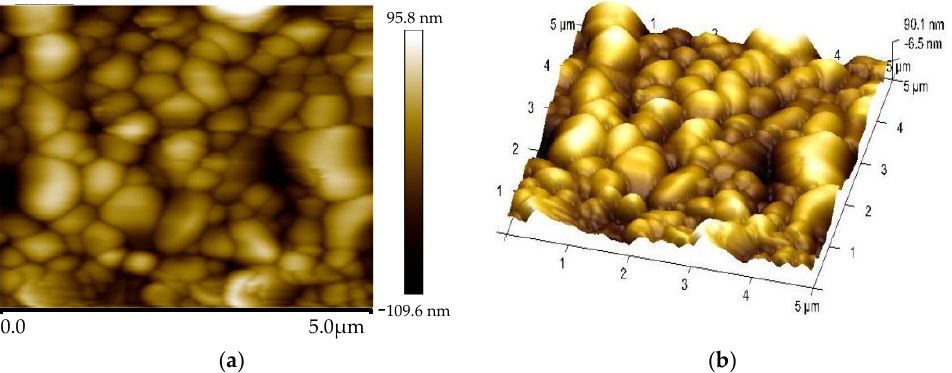
Figure 4. The AFM images of the CsPbBr 3 thin film. ( a ) AFM image; ( b ) corresponding 3D height image.